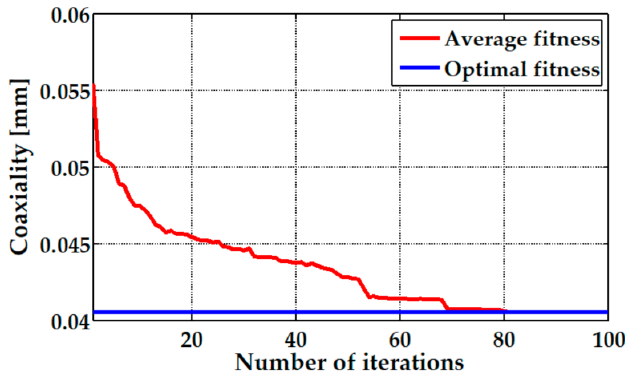
Figure 7. The convergence progress of the single-objective optimization for the coaxiality based GA.